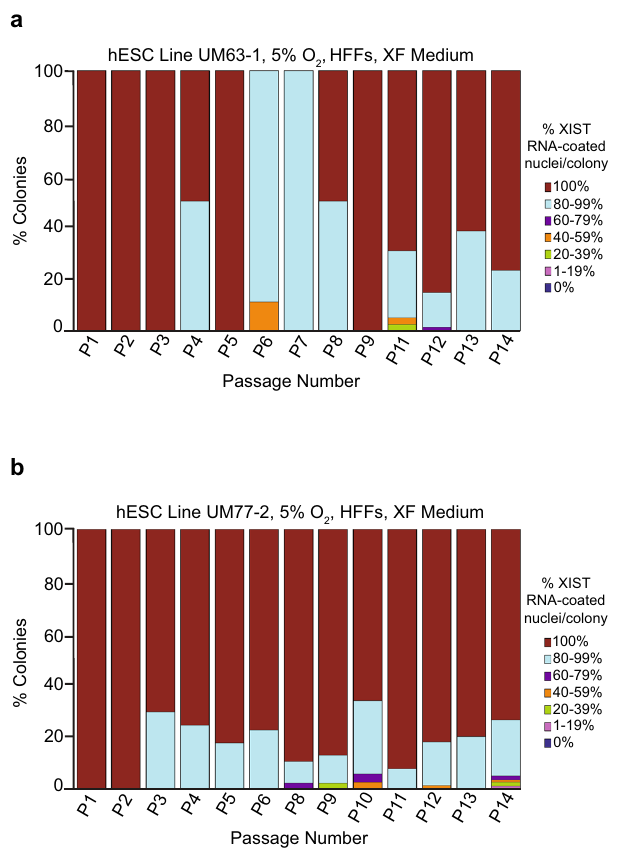
Fig. 3 Impact of culture surface on XIST RNA coating in female hESCs. a , b Percentage of nuclei with XIST RNA coats in colonies of hESC line UM63-1 ( a ) and UM77-2 ( b ) cultured on HFFs in XF medium under 5% O 2 concentration. The frequency of nuclei harboring XIST RNA coats per colony in either cell line when cultured on HFFs did not decrease signi fi cantly (general linear model, p = 0.09). At least 100 nuclei were counted per colony for hESC RNA FISH quanti fi cation. The total number of colonies quanti fi ed at each passage range between 1 and 126 and are cataloged in source data. Source data are provided as a Source Data fi P1-14 (Fig. 3; Source Data fi le). By contrast, as shown in Fig. 2, UM63-1 and UM77-2 hESCs cultured on Matrigel displayed an increasing percentage of colonies without any XIST RNA-coated nuclei through passaging (general linear model comparison, p < 0.001).